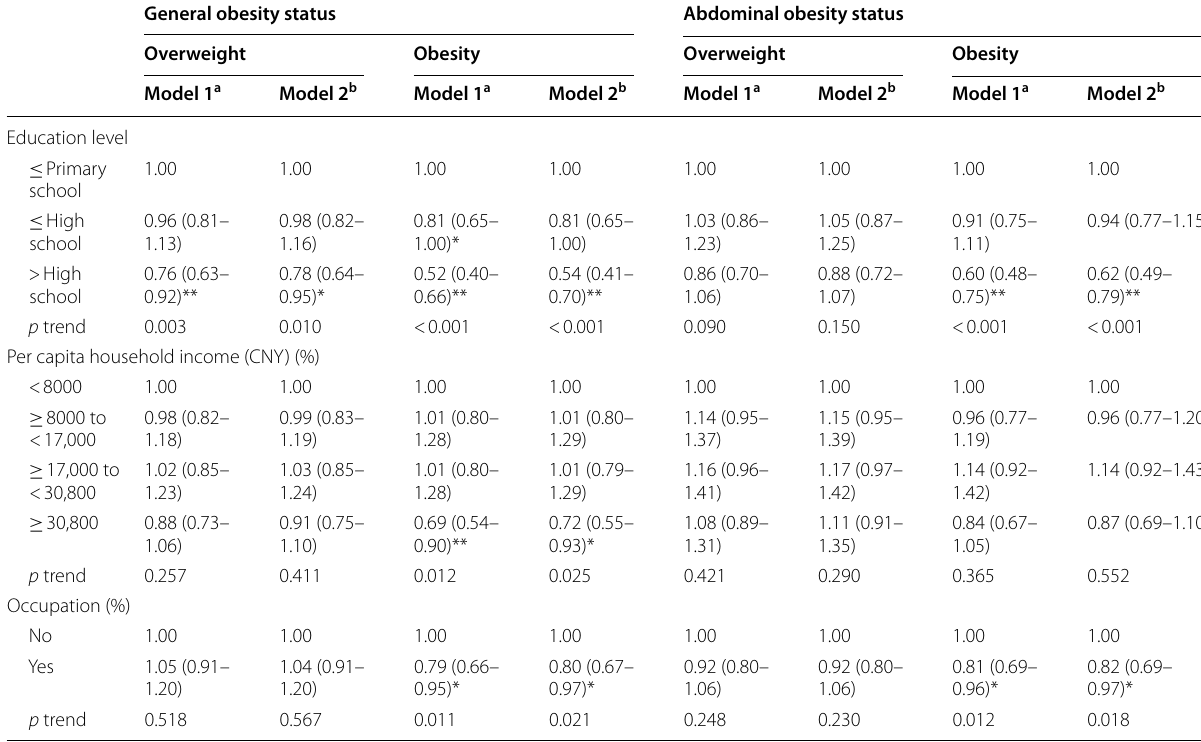
Table 3 Odds ratios (ORs) with 95% confidence intervals (CIs) of socio-economic factors related to overweight and obesity in